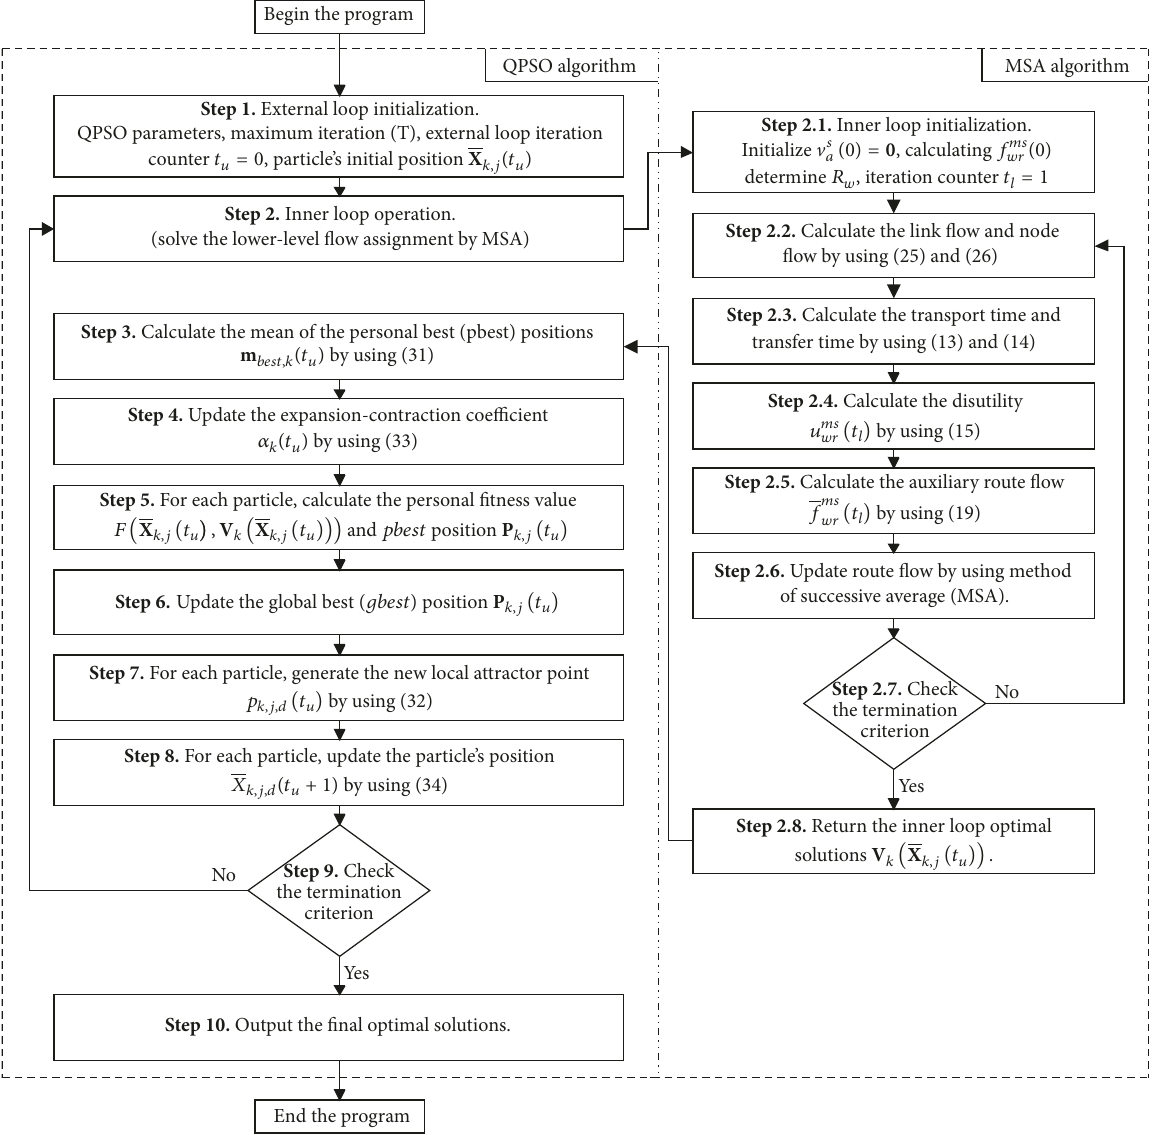
Figure 3: Flow chart of QPSO and MSA hybrid